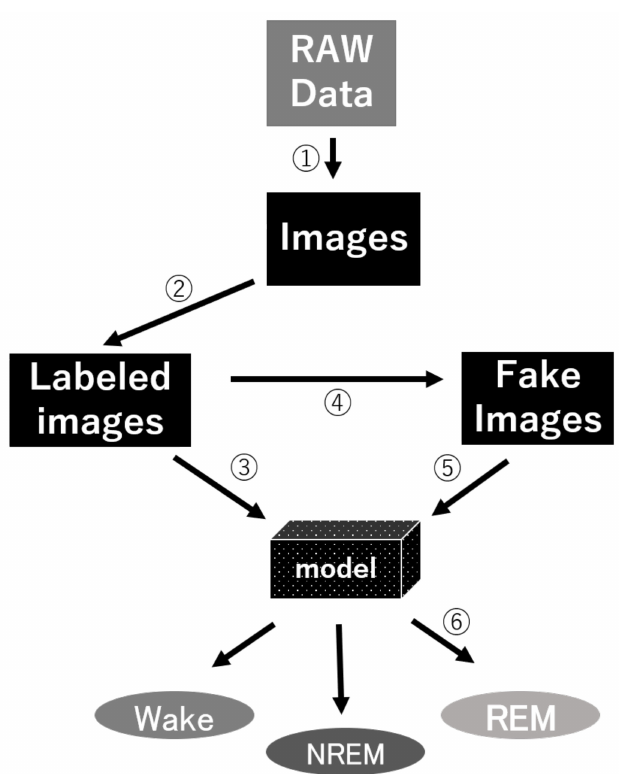
Figure 9. Our workflow diagram for GI-SleepNet: 1 (cid:13) image production based on raw data, 2 (cid:13) label the image data, 3 (cid:13) train the model, 4 (cid:13) generate fake data by GAN, 5 (cid:13) train the model with the generated images, and 6 (cid:13) make the prediction for new